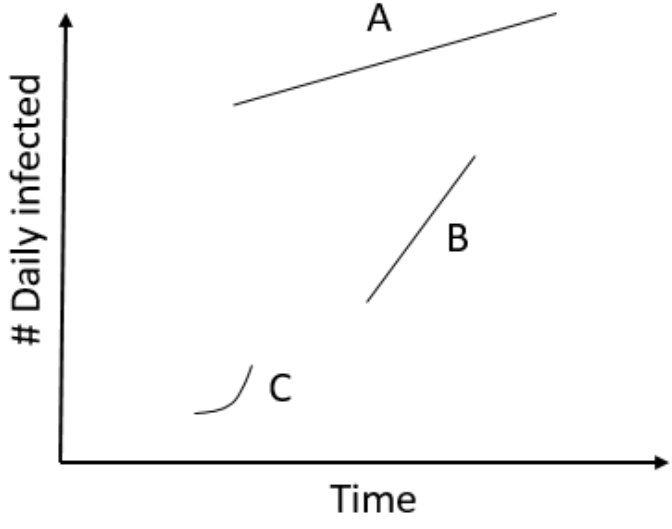
Figure 2. Hypothetical infection curves. Curve A represents a sample positive only according to the Avg. daily infections metric. Curve B is positive only according to the Reproductive rate , and curve C only according to the Exponential